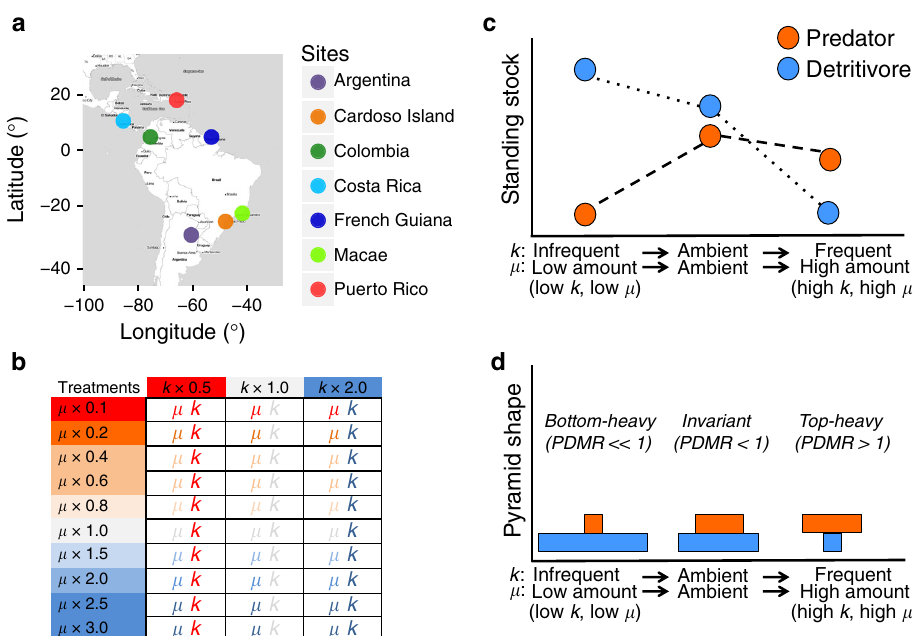
Fig. 1 Study sites, treatments and conceptual scheme depicting the predictions. a Study sites. b Treatment combinations designed to manipulate the quantity of rain entering the ecosystem (50 – 200%) and distribution of rainfall frequency (10 – 300%) relative to average ambient conditions of each site ( μ = 1, k = 1, in the centre of the table). Gradients of rainfall conditions, from severe drought to frequent rainfall, are represented by red and blue colours. k is the dispersion parameter (a measure of evenness in the frequency distribution of rainfall), and μ is the mean parameter (a measure of mean daily rainfall). These parameters were calculated per each site based on rainfall patterns of the last fi ve years before the beginning of each experiment (see “ Methods ” ). Stronger impacts of rainfall events are predicted when their components depart from current scenarios. c We predict that larger predators are more sensitive in environments experiencing infrequent and low rainfall amount (low k , low μ ), characterized as extreme drought conditions, than smaller organisms. Under these conditions we expect communities dominated by smaller organisms (detritivores and fi lter feeders), which tend to decrease in standing stock under more favorable conditions (ambient) via top-down control. In contrast, more frequent rainfall and high rainfall amount (high k , high μ ), characterized as heavy rainfall, could impact lower trophic levels through hydrodynamic perturbations (e.g., over fl ow of nutrients and basal resources). Bigger predators could be more resistant to fl ooding, but their biomass could decrease slightly via bottom-up effects. d Changes in standing stock, in turn, could alter predator – prey mass ratios (pyramid shape). Drought, ambient and heavy rainfall conditions could cause bottom-heavy, invariant and top-heavy biomass pyramids,